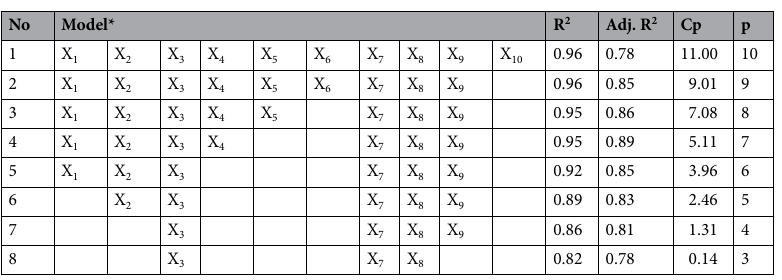
Table 7. Coefficients of determination (R 2 ), Adjusted (Adj) R 2 , C p and number of parameters (p) for the best models to predict body weight in Dorcas gazelle. *Body length [x 1 ], head length [x 2 ], neck length [x 3 ], ear length [x 10 ].